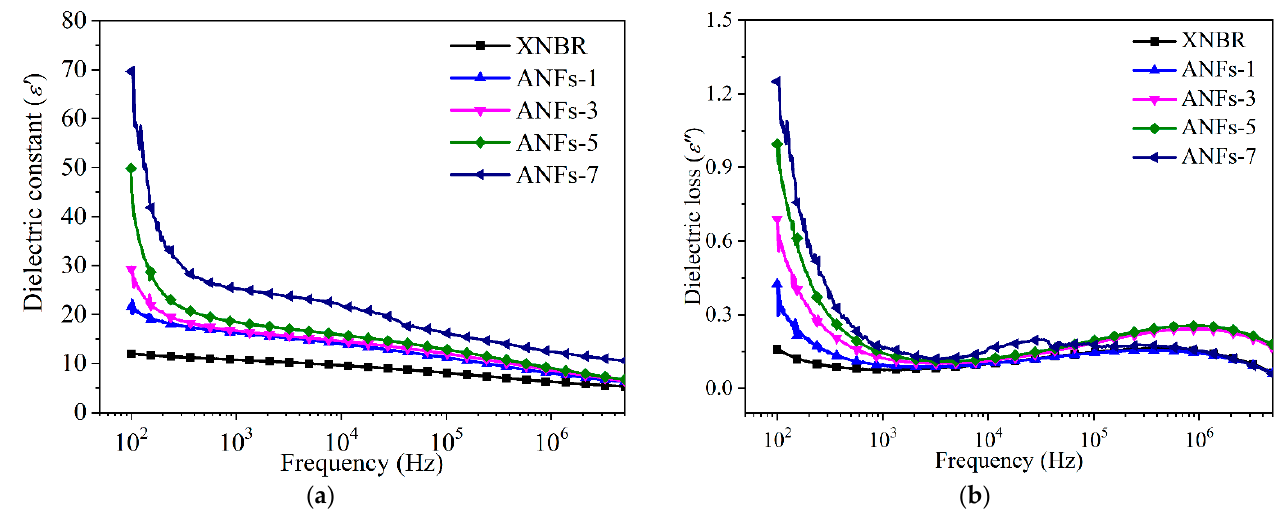
Figure 6. Dependence of ( a ) dielectric constants and ( b ) dielectric loss on the frequency of ANF/XNBR nanocomposites at room temperature.